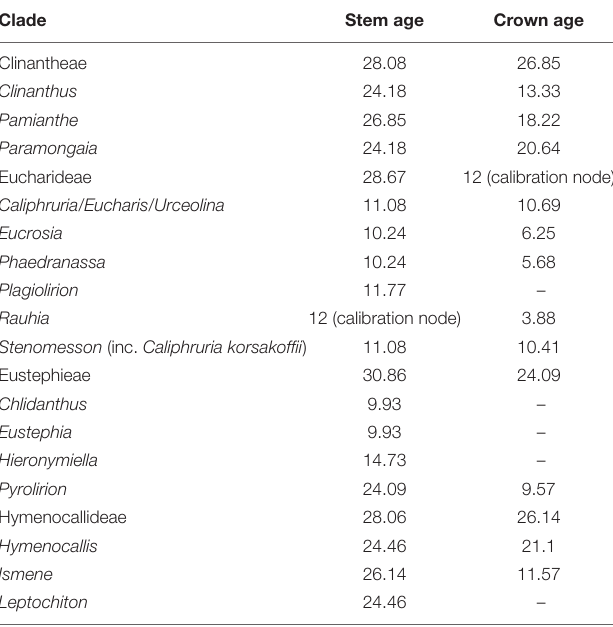
TABLE 1 | Estimated ages of major clades of the Andean tetraploid clade using penalized likelihood with the R package ape on the on the best 90% taxon coverage supermatrix tree found by maximum likelihood with